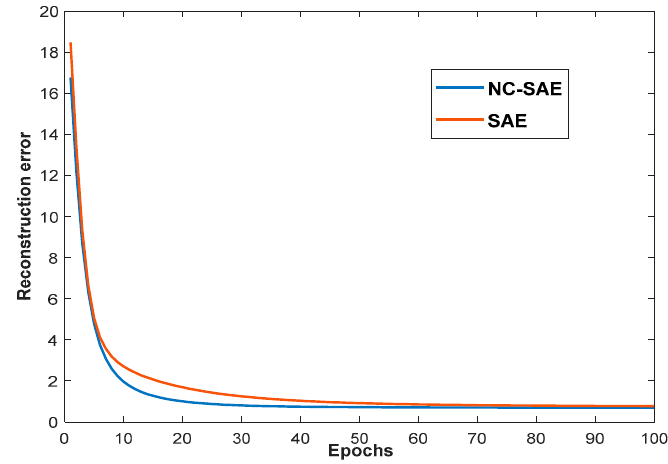
Figure 5. The reconstruction error curves of NC-SAE and SAE.